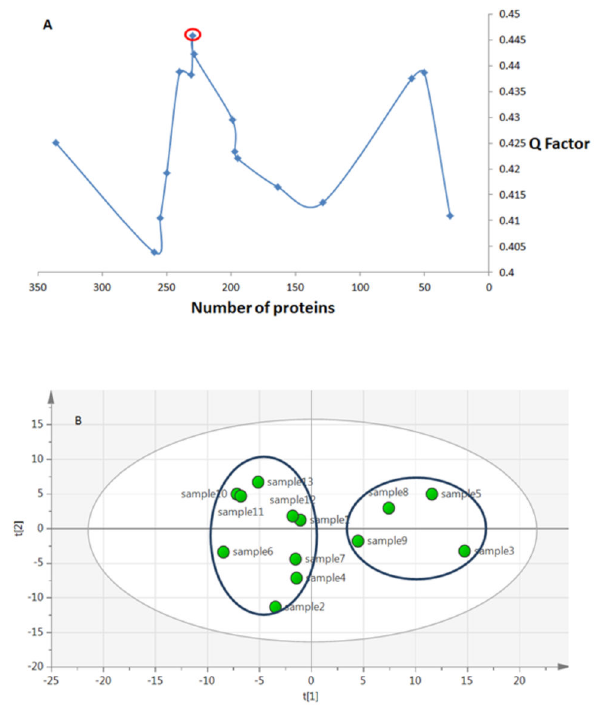
Figure 2. Quality factor plot for 1D GeLC-MS/MS. The best model corresponded to 230 proteins (A). Score plot of PCA using 1D GeLC-MS/MS (B). doi: